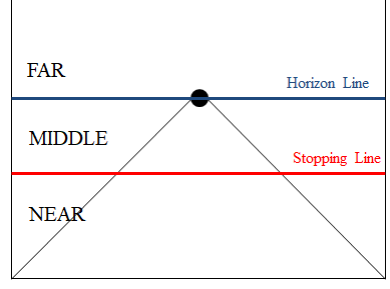
Figure 10. Conceptual classification of the pedestrian’s distance: The distance between a pedestrian and the ego-vehicle is classified as one of three regions, determined by the horizontal line passing through the vanishing point and the stopping distance line.